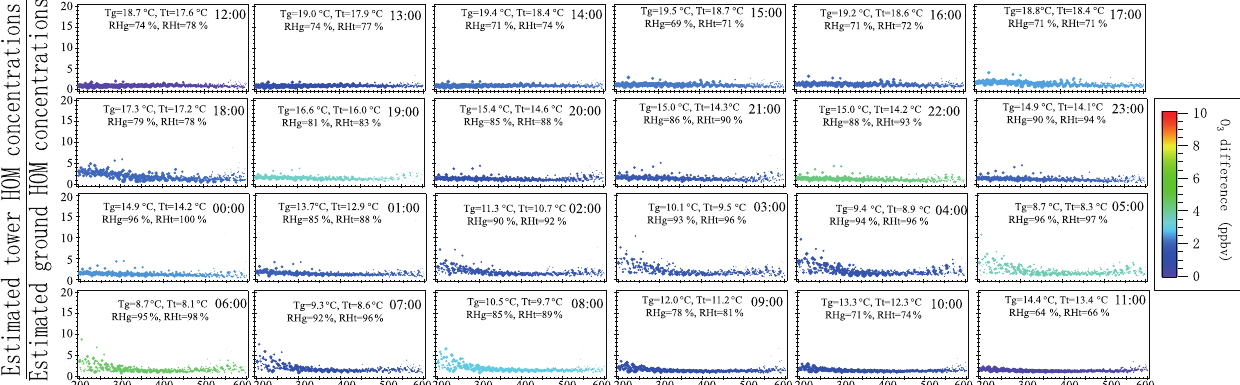
Figure 8. Hourly changes of the ratios between estimated tower and ground HOM concentrations from 12:00 on 11 September to 11:00 on 12 September (non-inversion night). Markers are sized by ground HOM concentrations and colored by the O 3 difference between the tower − O and ground ( O 3 3 ground ) . Hourly ambient temperatures at ground (Tg) and tower (Tt) levels and RH at ground (RHg) and tower (RHt) tower levels are shown in each